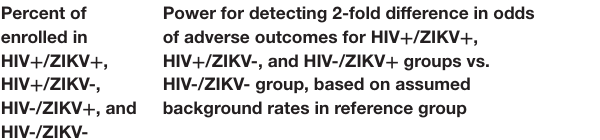
TABLE 3 | Power for detecting differences in rate of adverse pregnancy outcomes (for Aims 3 and 5) based on assumed proportion in the HIV and ZIKV co-infected, HIV- infected and ZIKV-infected groups as compared to the HIV and ZIKV-uninfected group. Power for detecting 2-fold difference in odds Percent of of adverse outcomes for HIV + /ZIKV + , enrolled in HIV + /ZIKV-, and HIV-/ZIKV + groups vs. HIV-/ZIKV- group, based on